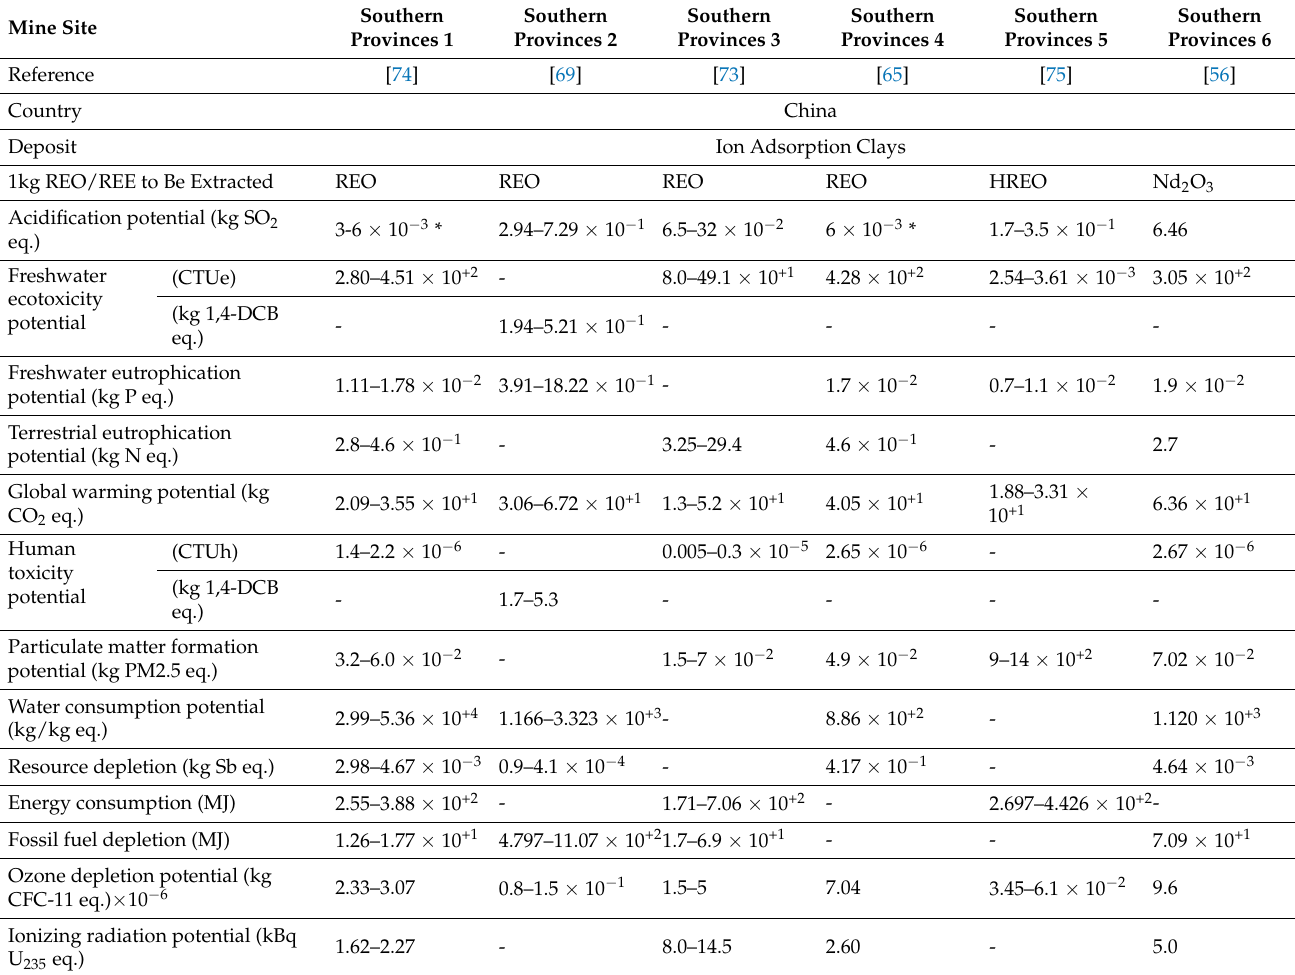
Table A3. LCA of REE primary production from ion-adsorption clays.